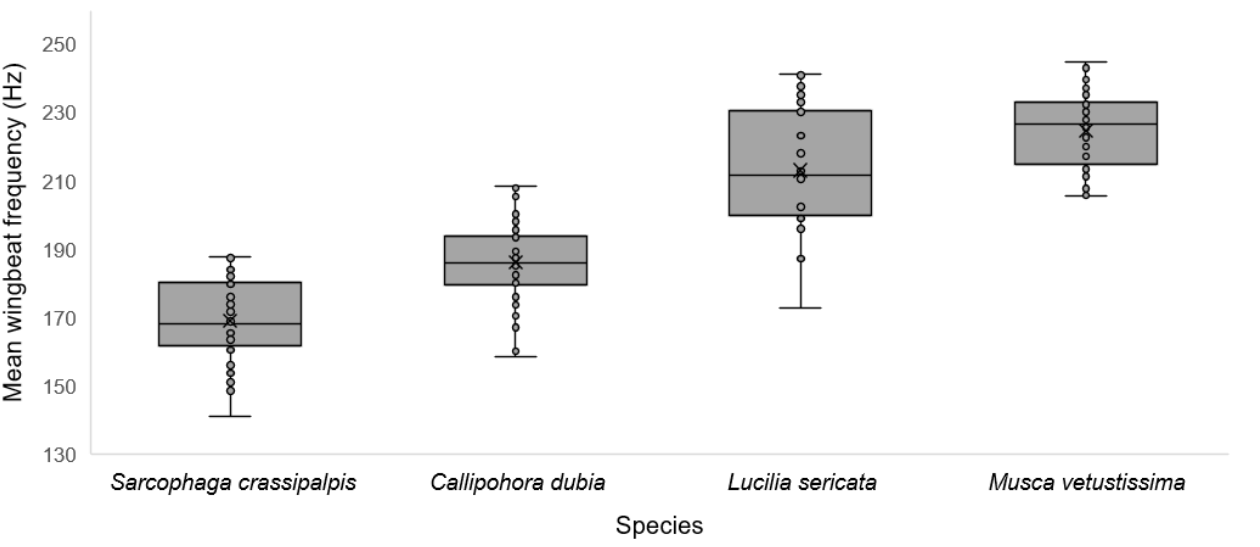
Figure 2. Mean wingbeat frequency of four recorded species. Mean is denoted with ‘X’ and upper and lower quartiles have been calculated using an inclusive median.